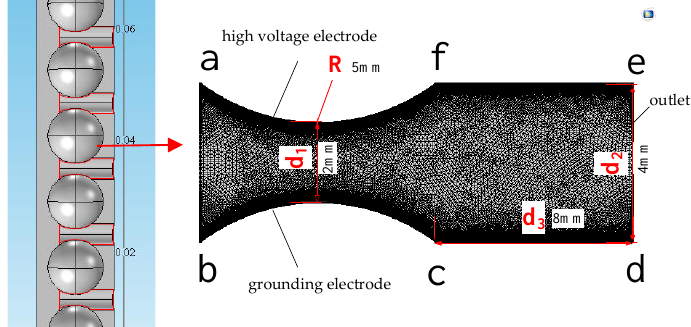
Figure 2. Simulation area and mesh generation of the basic SSAC structure.